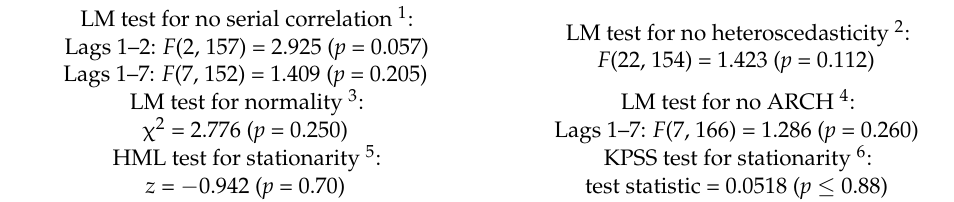
Table 2. Regression diagnostics for dfr regression results reported in Table